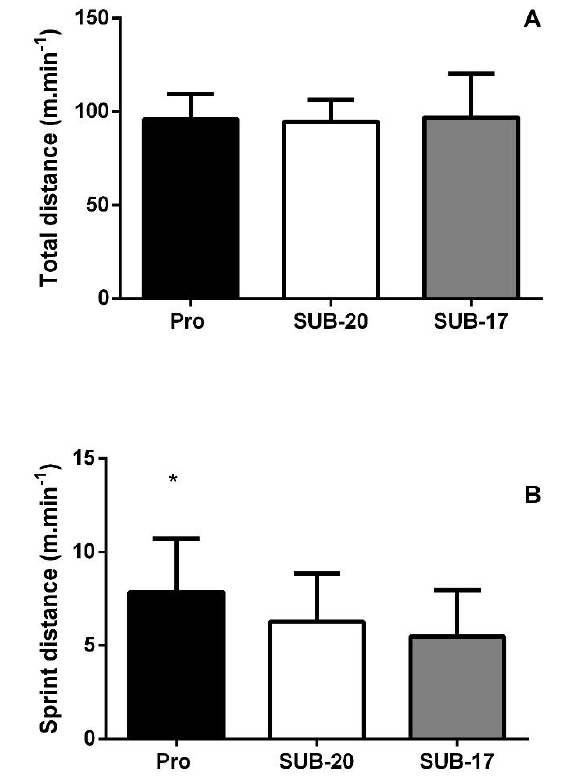
Figure 1. ( A ) Total distance (m · min − 1 ) and ( B ) Sprint distance (m · min − 1 ) in Pro, under-20 (U-20), and under-17 (U-17) groups. * p < 0.05 vs. U-20 and U-17. Table 1. Top speed and number of accelerations and decelerations for three age groups. Values are presented as mean ±